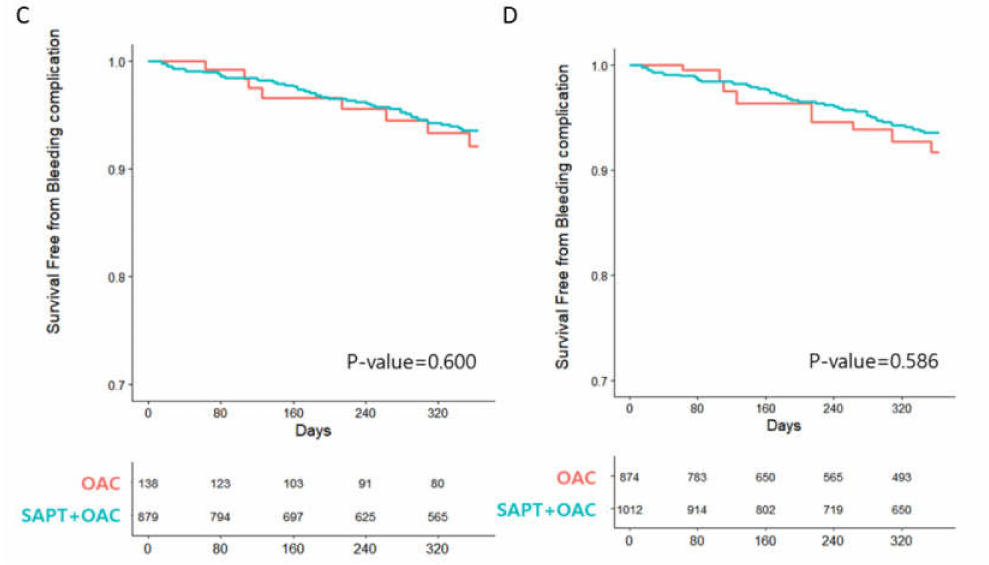
Figure 3. Kaplan–Meier curves of the crude population and inverse probability of treatment weight- ing (IPTW) population for the clinical outcomes in OAC with SAPT and OAC monotherapy. MACE of ( A ) unadjusted and ( B ) IPTW-adjusted population; bleeding complication of ( C ) unadjusted and ( D ) IPTW-adjusted population. MACE, major adverse cardiac events; OAC, oral anticoagulant; SAPT, single antiplatelet